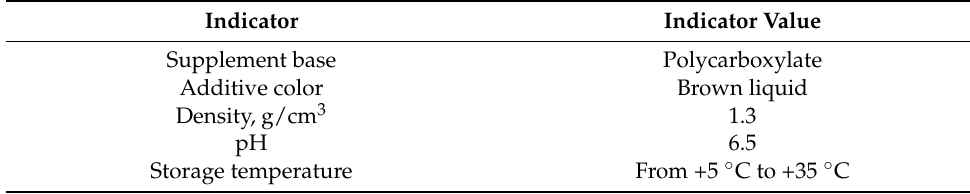
Table 6. Technical description of sodium sulfate. Indicator Value Appearance Free-flowing white powder Mass fraction of sodium sulfate, (Na 2 SO 4 ), % 99.5 Mass fraction of water-insoluble residue, %